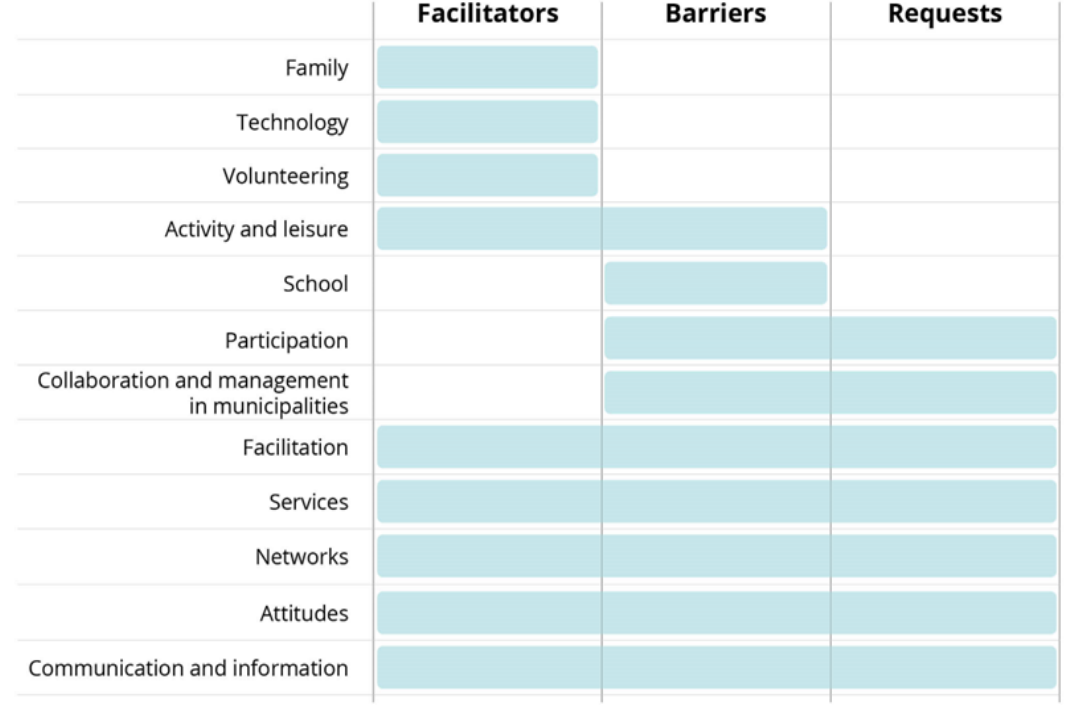
Figure 3. High-level Analyses of Cross-Cutting Themes (three municipalities).